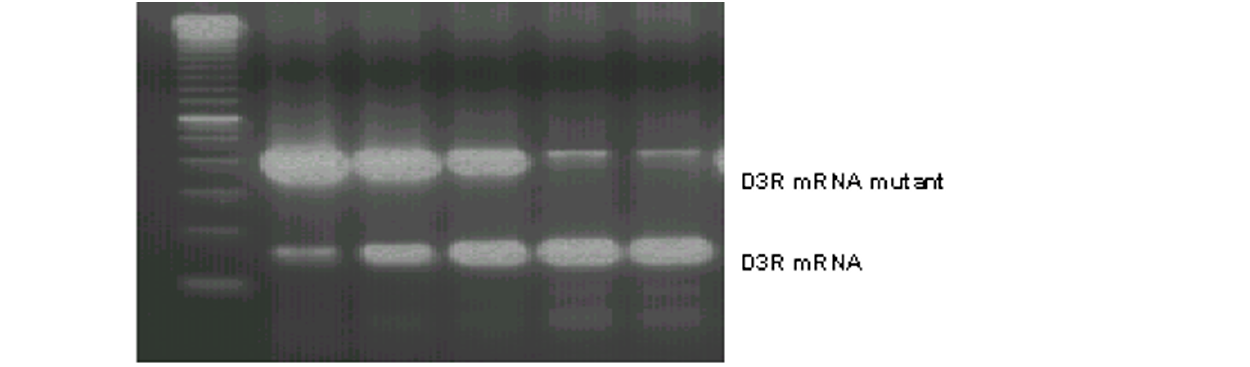
Figure 1 Examples of quantitative RT-PCR of D3R mRNA in one patient. Upper band represents the D3R mutant that com-